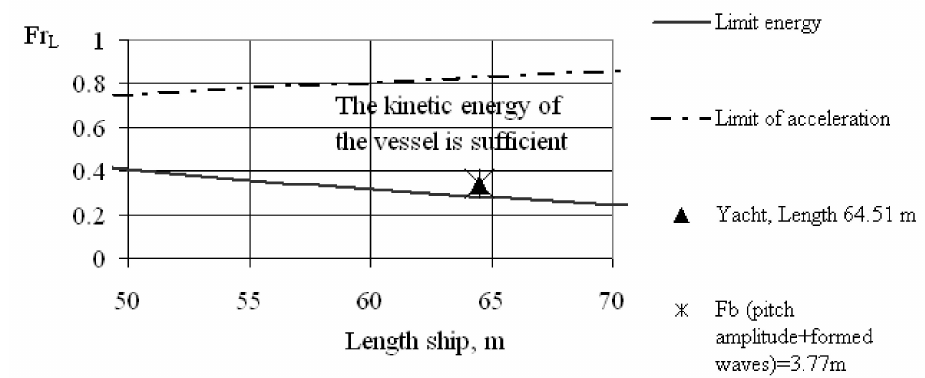
Figure 7. A comparison of the energies of the yacht (length 64.51 m) and the energy of a wave with a height h 3% = 5.5 m ( h 1/3 = 4.1